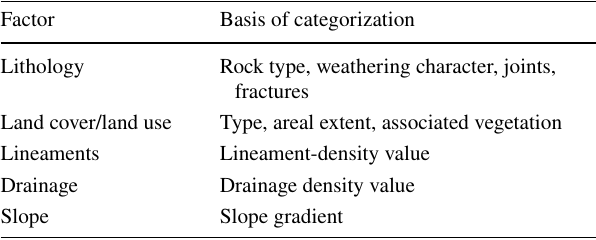
Table 1 Factors influencing groundwater recharge